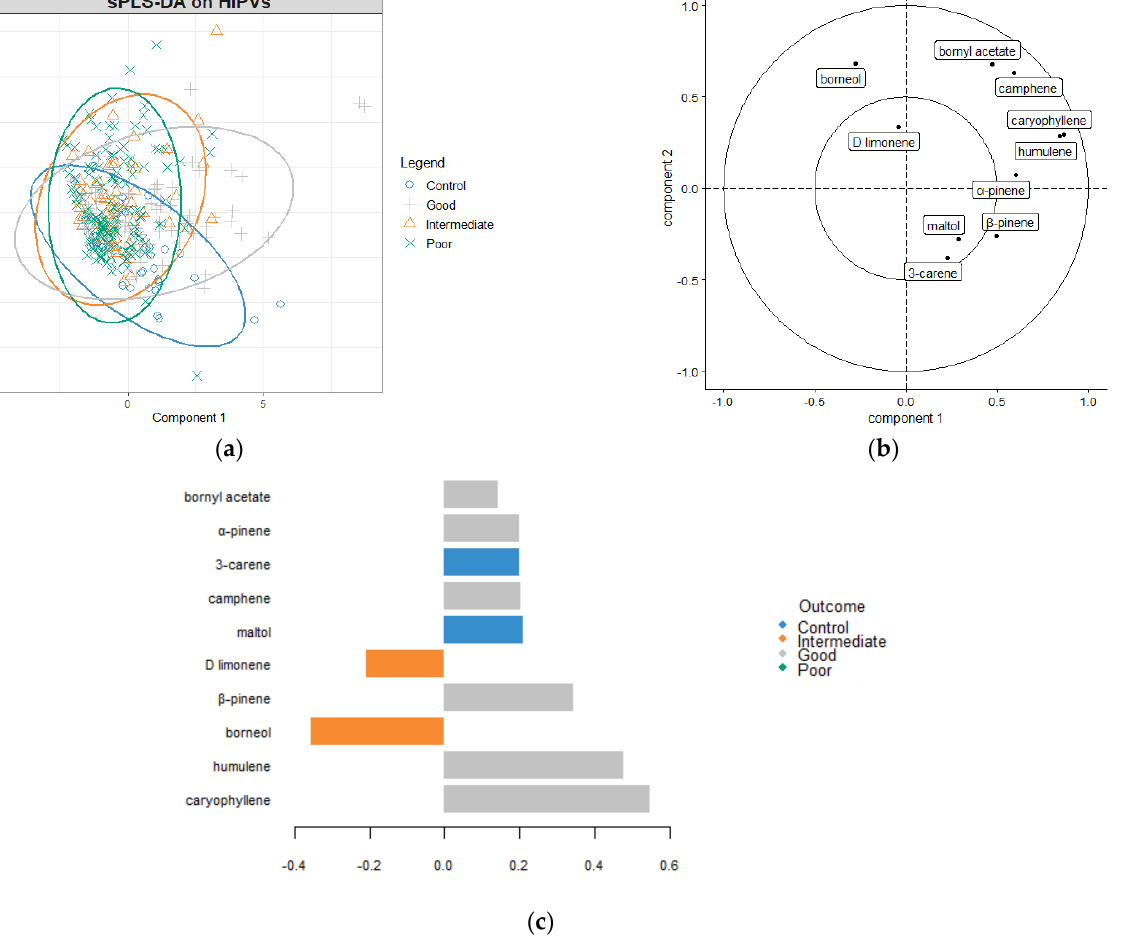
Figure 2. Results of sPLS-DA analysis. ( a ) sPLS-DA components 1 and 2, describing 48% of total data variance, ( b ) correlation circle plot on sPLS-DA components 1 and 2, and ( c ) visual representation of sPLS-DA variable contributions based on component 1. Contributions are ranked from the bottom (important) to the top (less important). Color denotes the associated performance group.